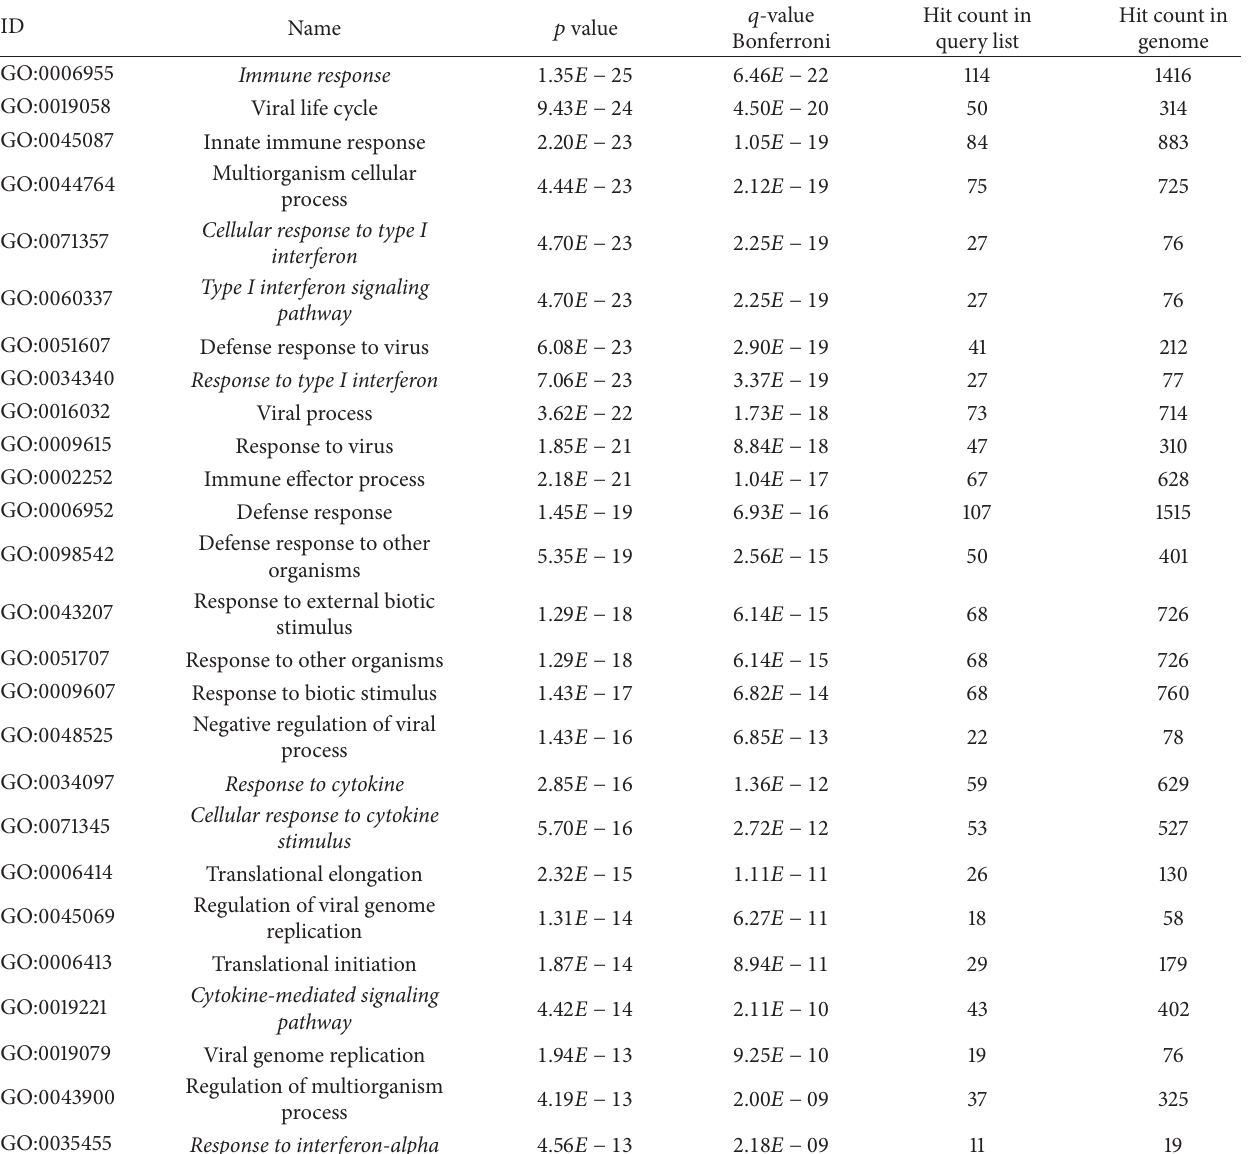
Table 2: Functional enrichment analysis from ToppGene. Hit count in query list is the number of genes from the list of significantly differentially expressed genes in that ontology. Hit count in genome is the number of described genes in the